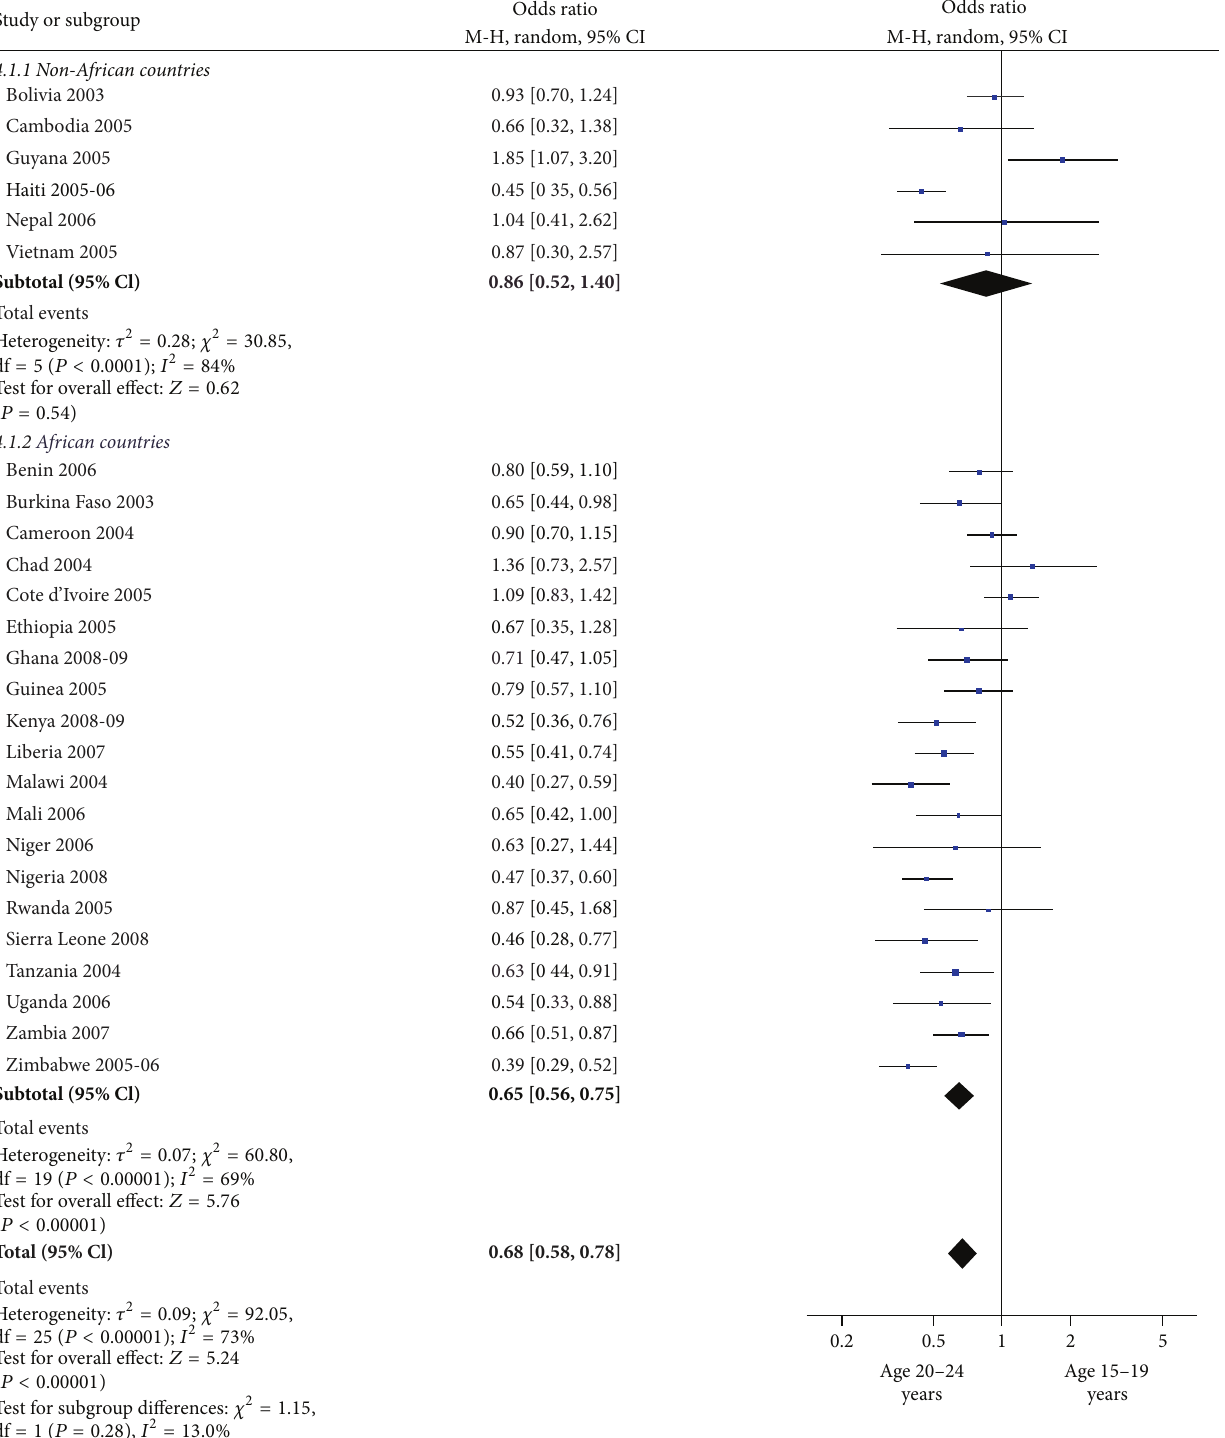
Figure 4: Condom use during last higher-risk sexual encounter by age group (2003–2009). M-H = Mantel-Haenszel statistic; CI = confidence